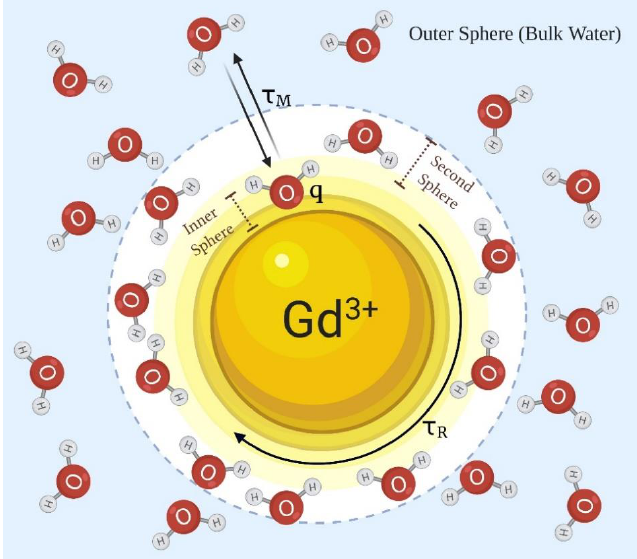
Figure 1. The variables that contribute most to the relaxation efficiency (r 1 ) of a Gd 3+ -based contrast agent include the hydration number (q), the mean residence lifetime of the inner-sphere water molecule (τ m ), and the rotational correlation time (τ R ) of the entire Gd 3+ -complex.